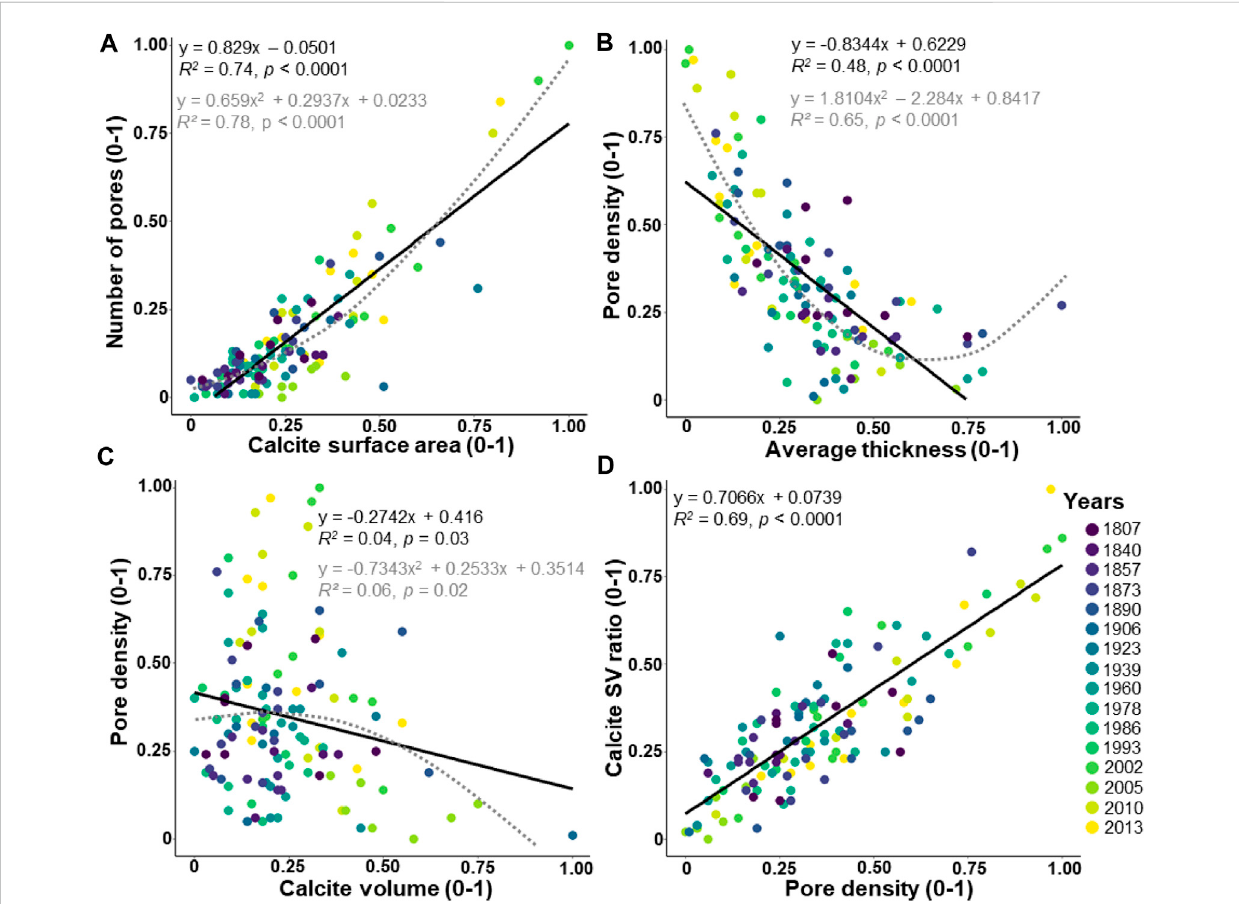
FIGURE 6 Relationships between the pore pattern and the other morphological parameters. The values are adjusted between 0 and 1. The dataset includes 124 specimens of Elphidium clavatum from the Baltic Sea entrance over thelast 200 years. (A) Number of pores and calcite surface area. (B) Pore density and average thickness. (C) Pore density and calcite volume. (D) Calcite SVratio and pore density. Linear correlation (black line). Polynomial function (grey dotted